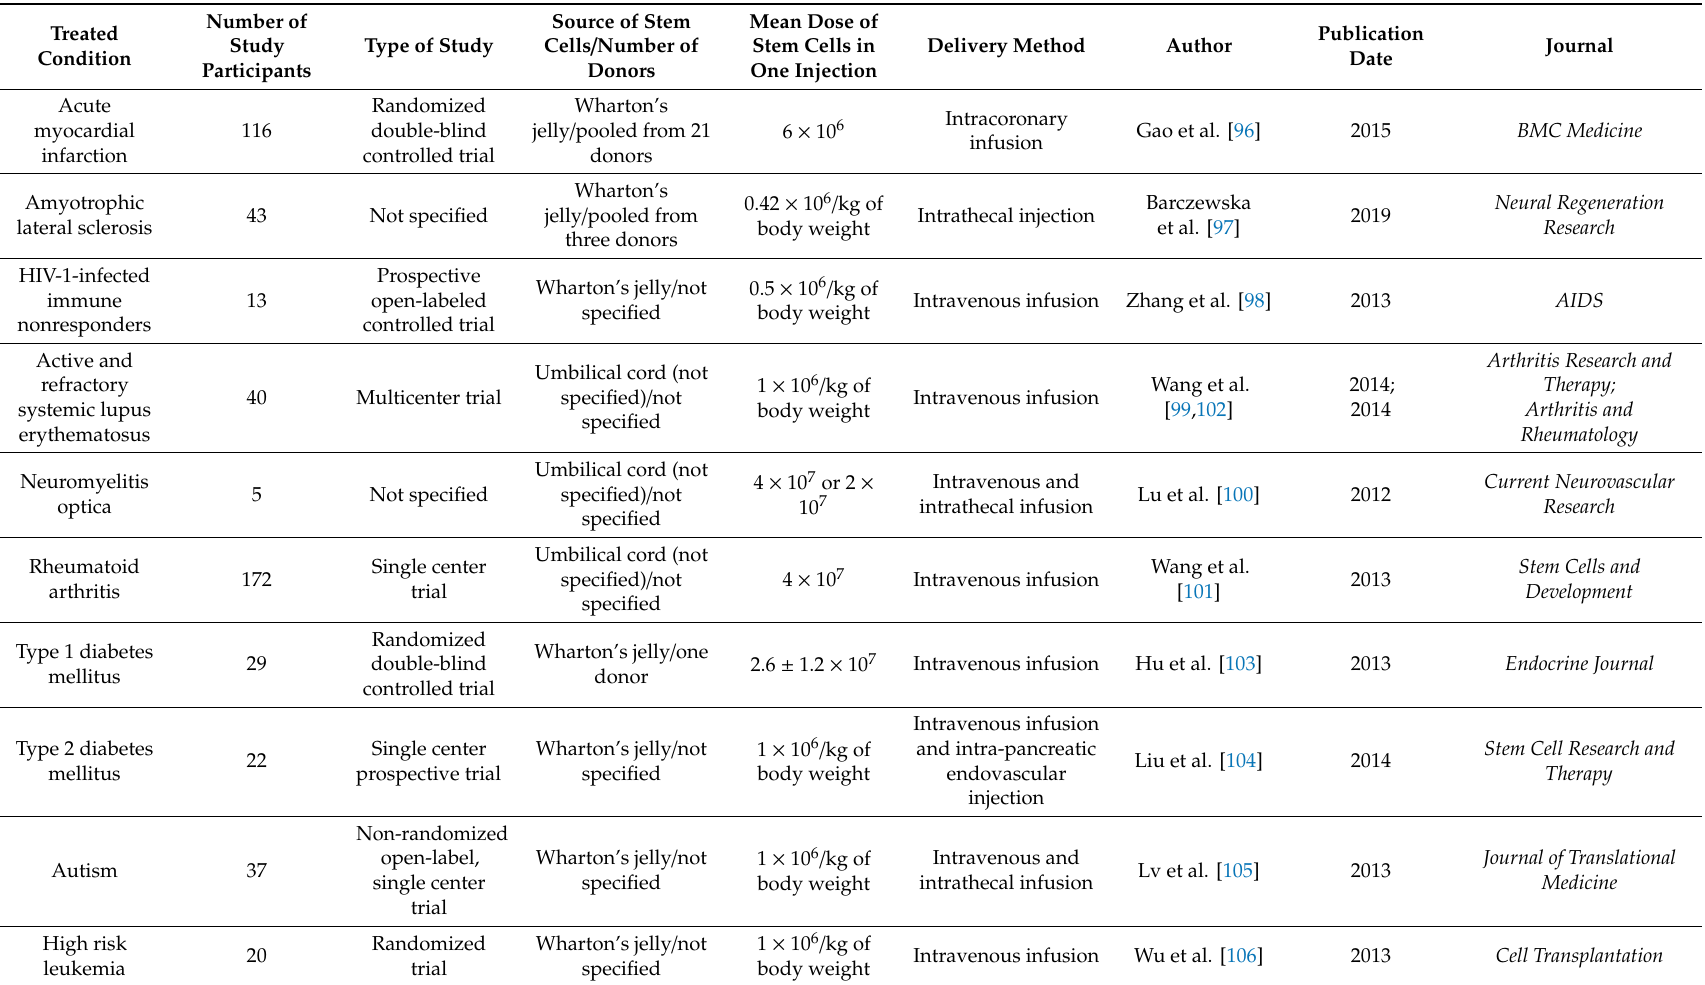
Table 2. Clinical trials with the use of stem cells from human umbilical